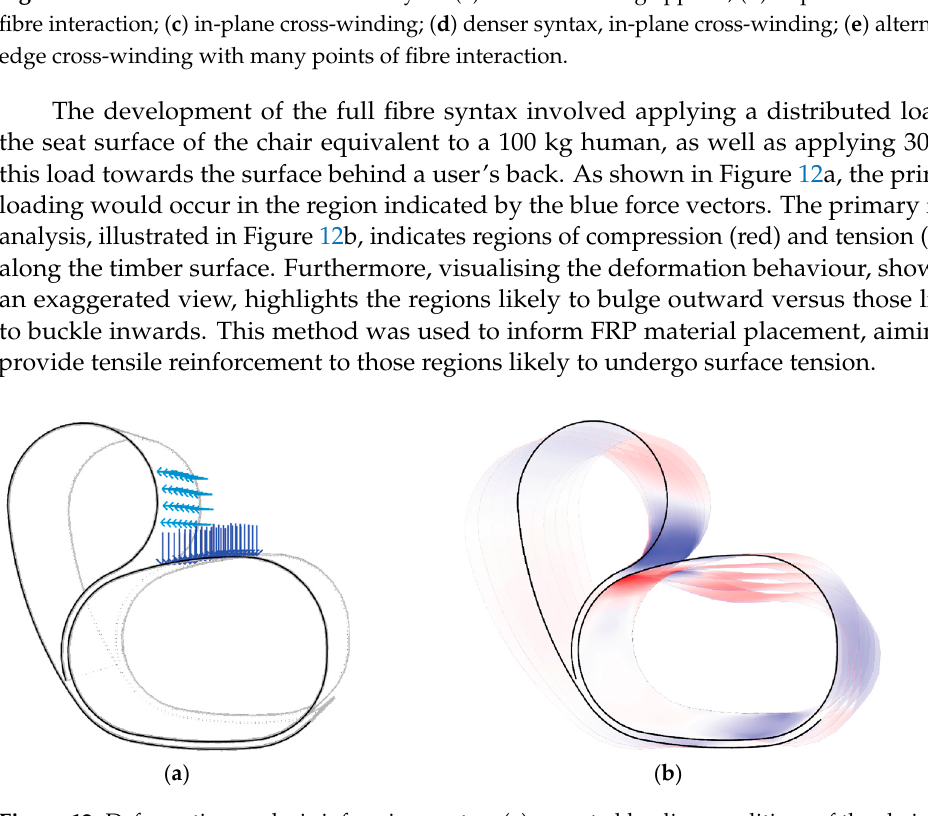
Figure 12. Deformation analysis informing syntax: ( a ) expected loading conditions of the chair, with 100 kg distributed load applied to the seat and an additional 30% applied to the back; ( b ) exaggerated deformation behaviour of the chair under applied